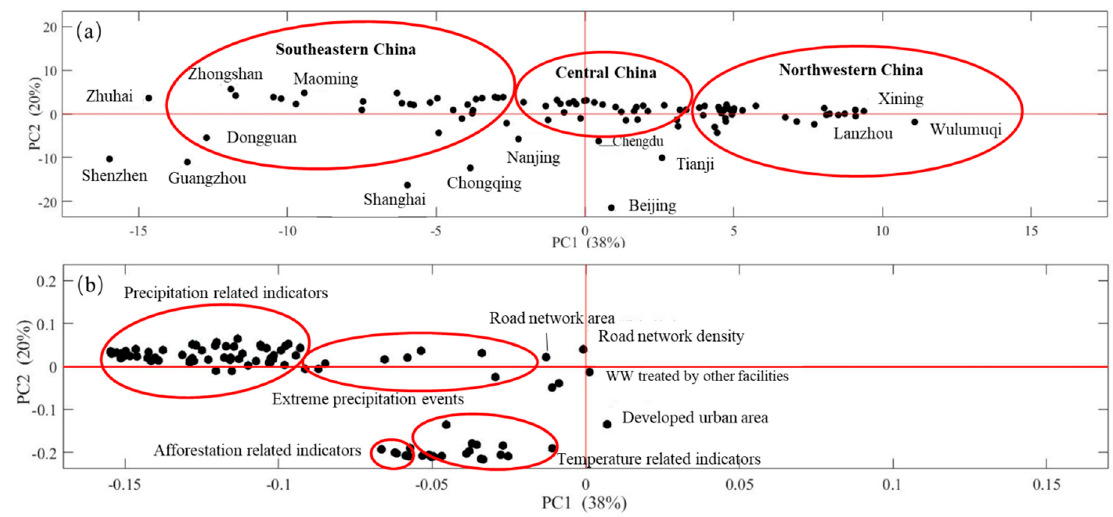
Figure 3. Principle component analysis (PCA) score ( a ) and loading ( b ) plots.